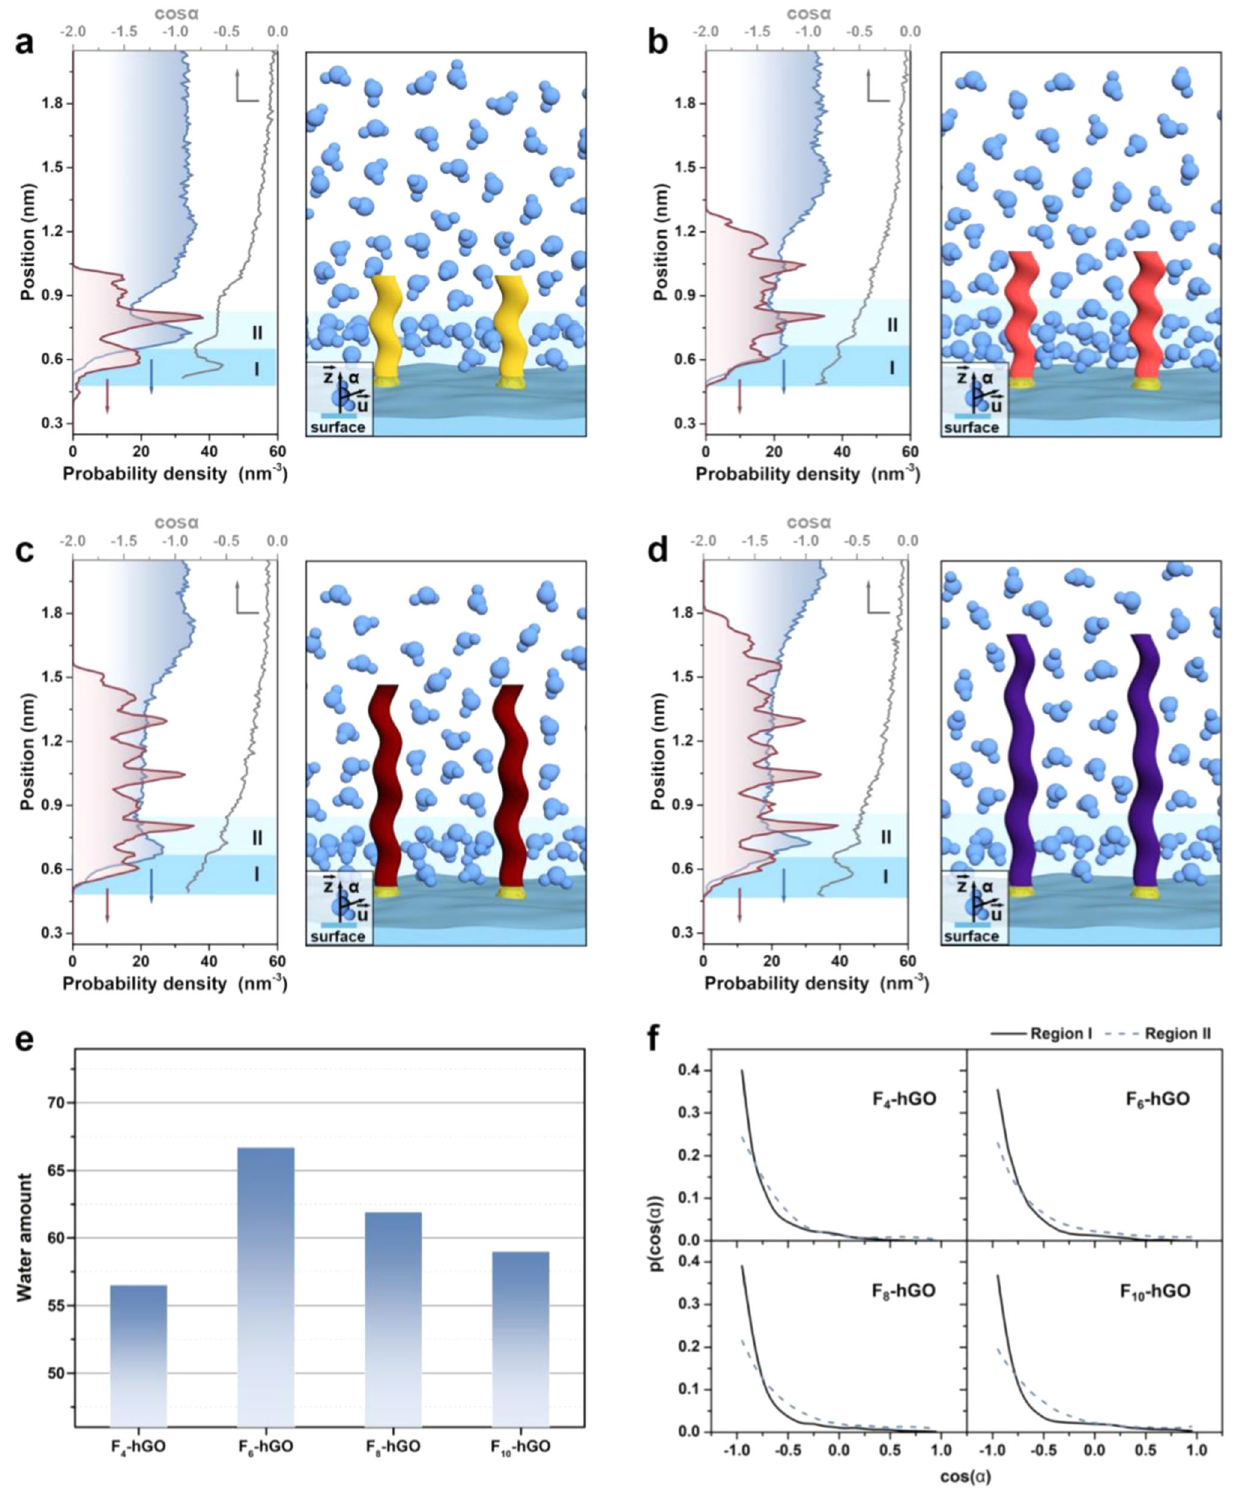
e Water amount in the hydration layer of the proposed surfaces. f Probability dis- tributions of the orientation of the water in the hydration layer of the proposed surfaces. Solid and dashed lines are the distributions for regions I and II, respec- tively. Source data are provided as a Source Data fi